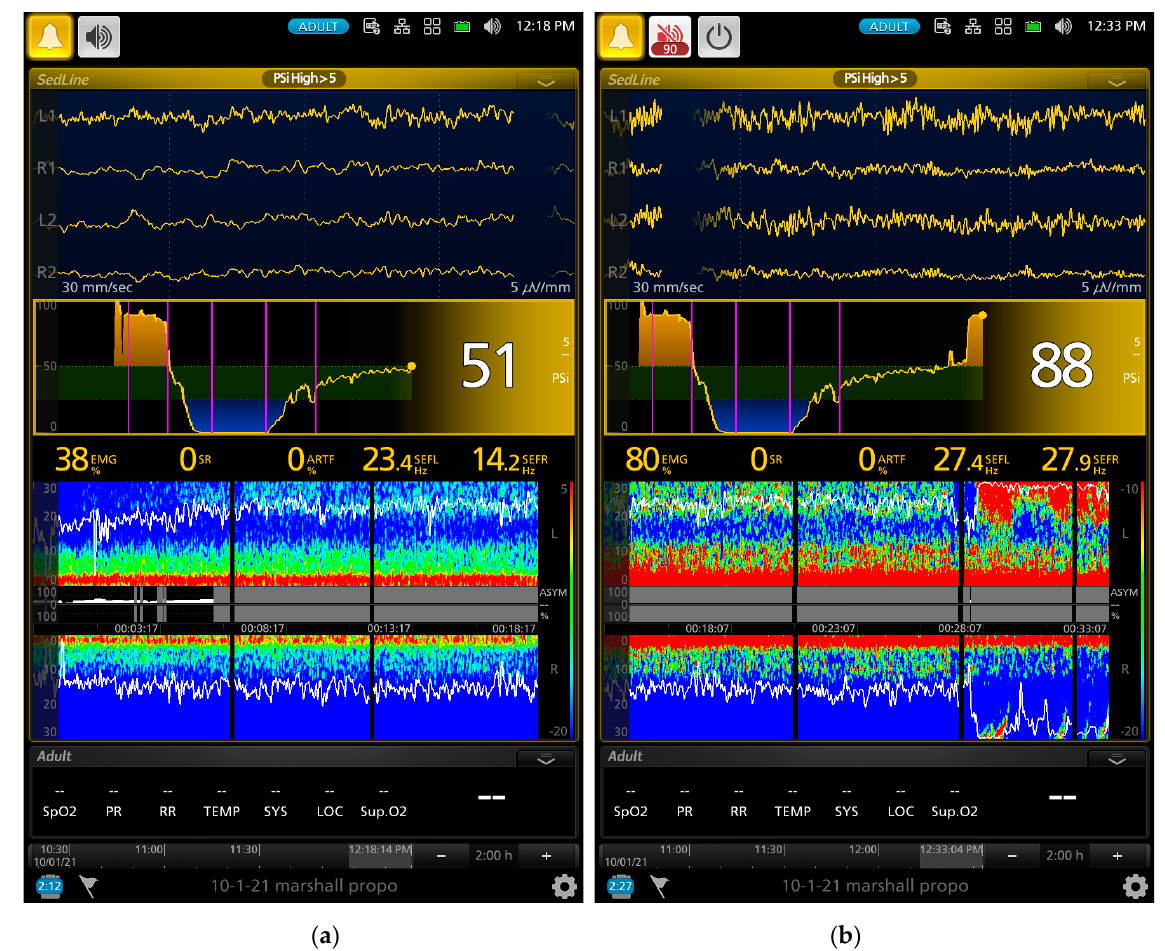
Figure 5. The screenshots of the same dog presented in Figures 2–4. The Figures showed the early and late phases of recovery of the dog after the termination of propofol CRI. The 5 vertical pink lines (from the left to right of the screen) indicate the initiation of propofol induction, beginning of the 2.4, 1.6, and 0.8 mg/kg/min of propofol CRI and termination of the propofol CRI, respectively. The EEG waveforms in ( a ) show a transition of continuation of delta–theta (the bright color of the spectrogram) anesthesia and the appearance of low and high beta waves with SEFL 95 and SEFR 95 of 23.4 and 14.2. The PSI value increased from the previous 26 to now 51. The PSI trend in ( b ) gives an overview of the entire propofol anesthesia from the awake brain state (yellow shade area on the left side of the trend map) to loss of consciousness after induction, to profound anesthesia with burst suppression and to regain of consciousness in the recovery phase (yellow shade area of the right side of the trend map) to recovery with the PSI value of 88. The high EMG activity (80%) together with high beta power can be seen in the DSA as the bright color between 20 and 30 Hz in ( b ). The SEFL 95 and SEFR 95 were 27.4 and 27.9 Hz, respectively. With the change of the DSA scale from ( a ) to ( b ), the alpha power can be seen with delta and theta power in ( b ). Table 1. Mean (±SD) EEG index values of six dogs anesthetized with propofol. Propofol anesthesia was divided into awake (phase 0), graduate induction at 1 mg/kg/min (phase 1), 2.4 mg/kg/min CRI There was a strong correlation between PSI and SR ( ρ = − 0.86, negative correlation due (phase 2), 1.6 mg/kg/min CRI (phase 3), 0.8 mg/kg/min (phase 4), recovery to extubation (phase 5), to the same effect with opposite values of these two indices). The MBP was most correlated and recovery to sternal recumbency (Phase 6). The indices were PSI (patient state index), SR (burst to anesthetic depth score ( ρ = 0.76) and then to PSI values ( ρ = 0.71). The anesthetic depth suppression ratio), EMG (% of electromyographic activity), ART (% of artifact activity), SEFL, and score was most correlated to the PSI ( ρ = 0.75) and then to SR ( ρ = 0.70). The PSI and EMG SEFR (95% of the spectral edge frequency on the left and right hemisphere of the cortex). For statis- correlation was 0.52. The correlation between HR and MBP ( ρ = 0.27), anesthetic depth tical significance please see the text. score ( ρ = 0.05), PSI ( ρ = 0.04), and SR ( ρ = 0.05) were all